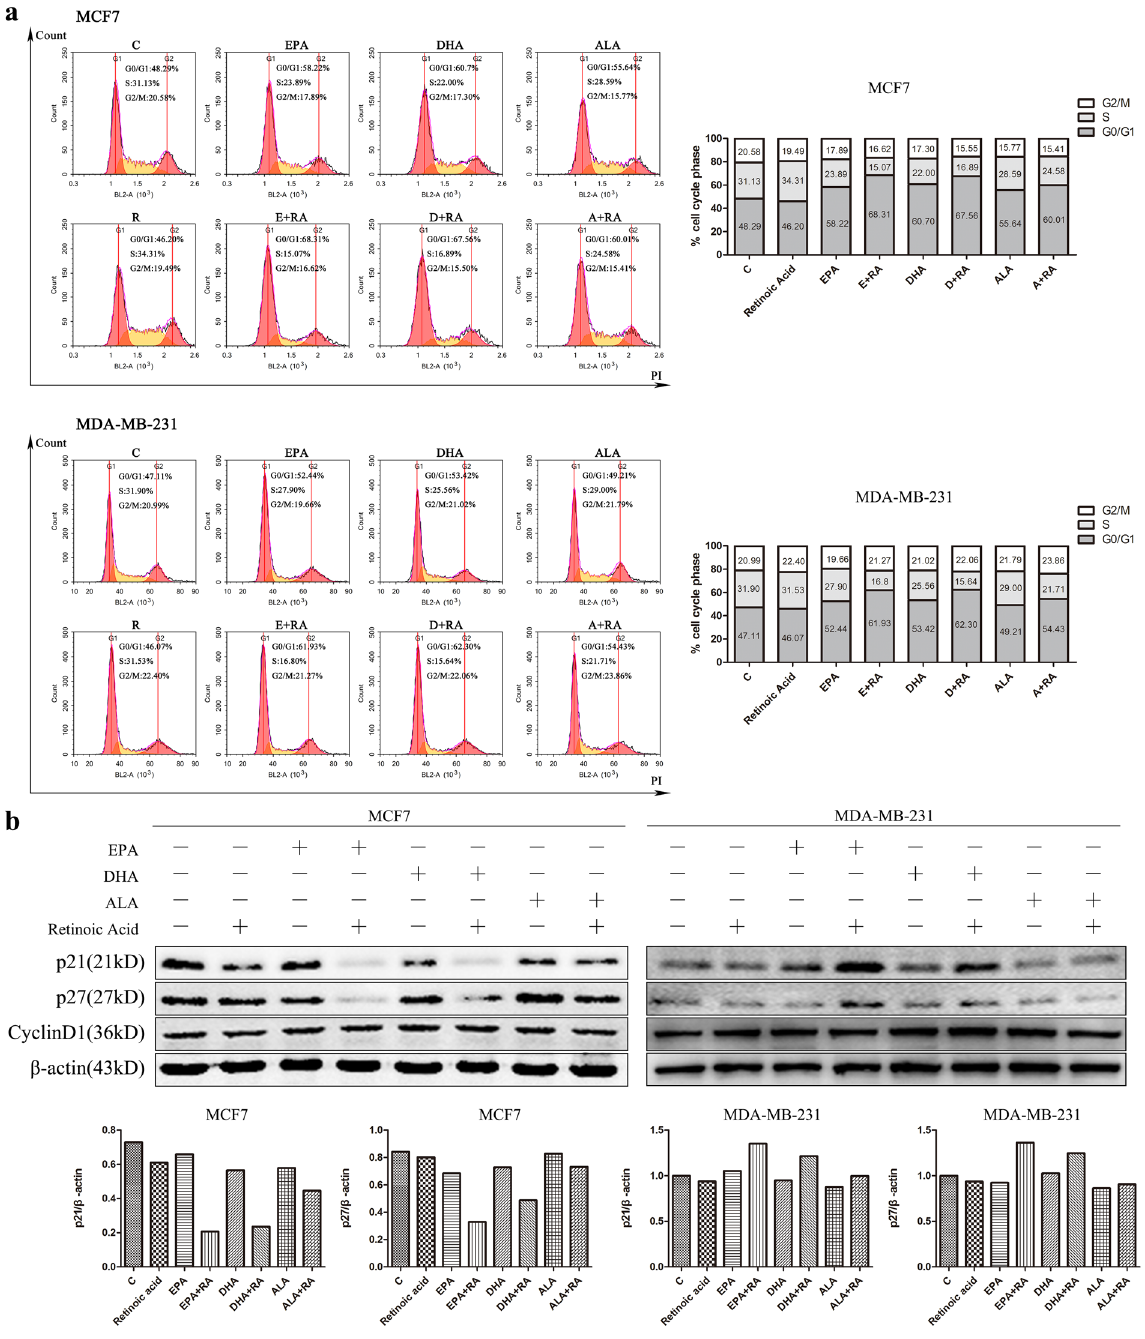
Figure 2. Cell cycle. MCF7 and MDA-MB-231 cells were treated with 80 μ M ω - 3 FFAs and 20 μ M ATRA alone or in combination for 24 h. ( a ) Cell cycle was analyzed by flow cytometry (upper panel) and percentages of the total cell population in the different phases of cell cycle. ( b ) The expression of p21, p27 and cyclin D1 protein and quantification of p21, p27 and cyclin D1 (relative to β